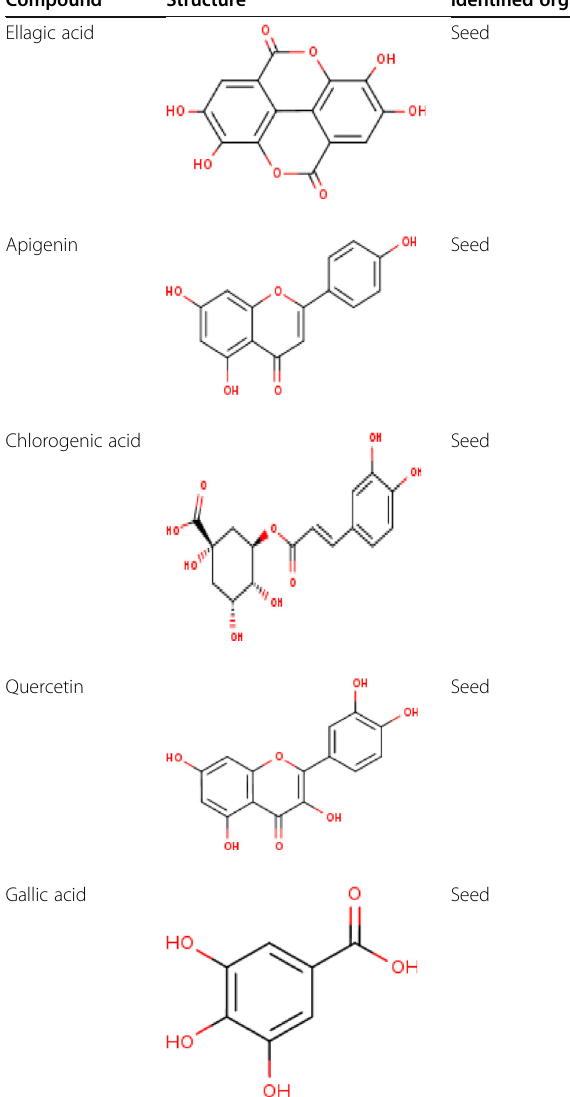
Table 2 Phenolics from morphological organs of H. umbellate